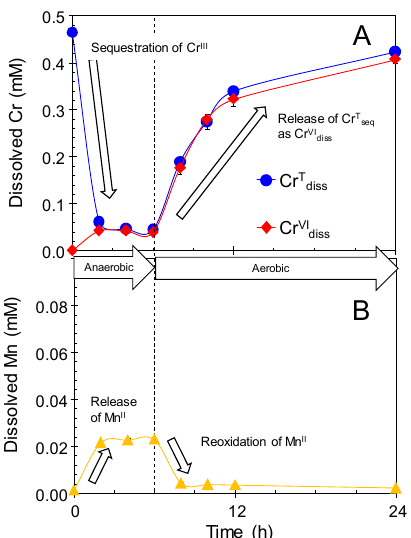
Figure 6. Concentrations of ( A ) total Cr dissolved (Cr T diss ), Cr(VI) dissolved (Cr VI diss ), and ( B ) Mn(II) released (Mn II rel ) in single treatment of newly formed BMO (1 mM as Mn) in 0.5 mM Cr(NO 3 ) 3 (100 mM MES at pH 6.0) under anaerobic and subsequently aerobic conditions.